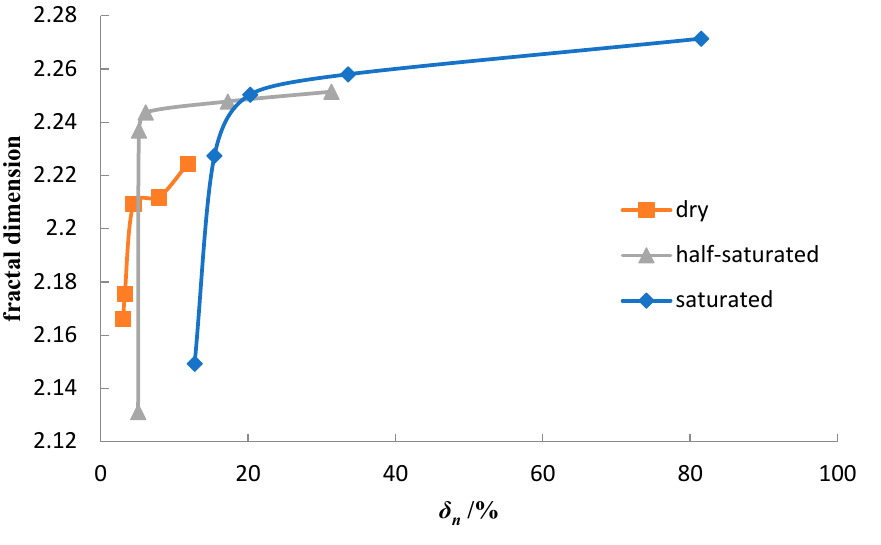
Figure 17. The relationship curve of fractal dimension— δ n .